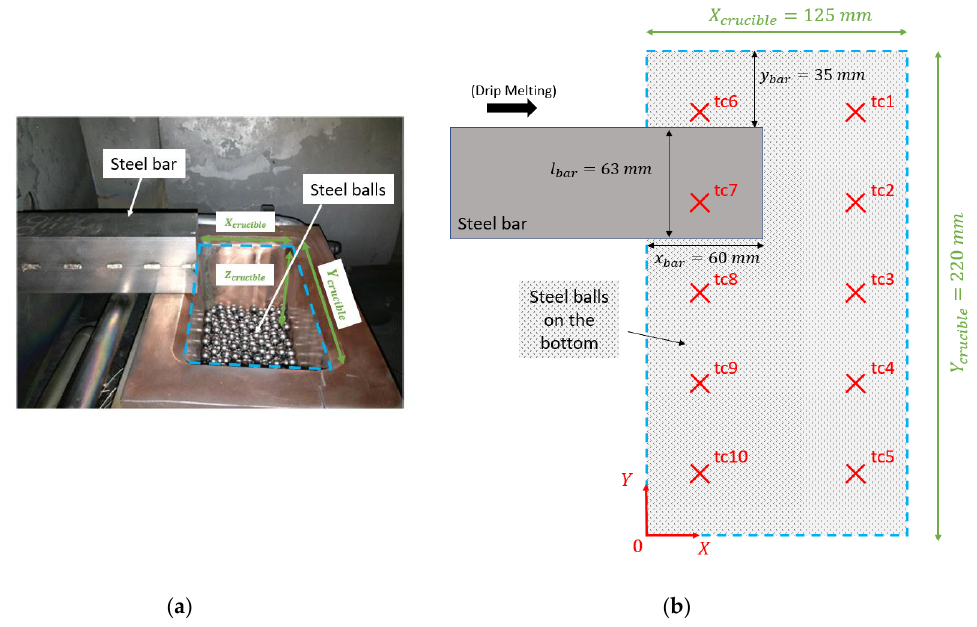
Figure 3. Set-up of the water-cooled copper crucible. Picture of the crucible ( a ); top view (XY) of the crucible and locations of the thermocouples ( b